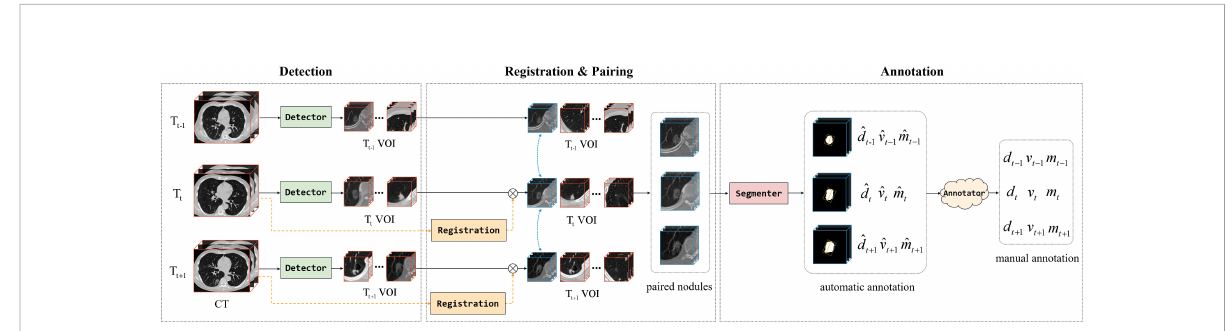
FIGURE 3 The pipeline of organizing the dataset, including CT scan registration, ROI pairing, and class annotation. The letters d, v, and m denote the diameter, volume, and mass of lung nodules,